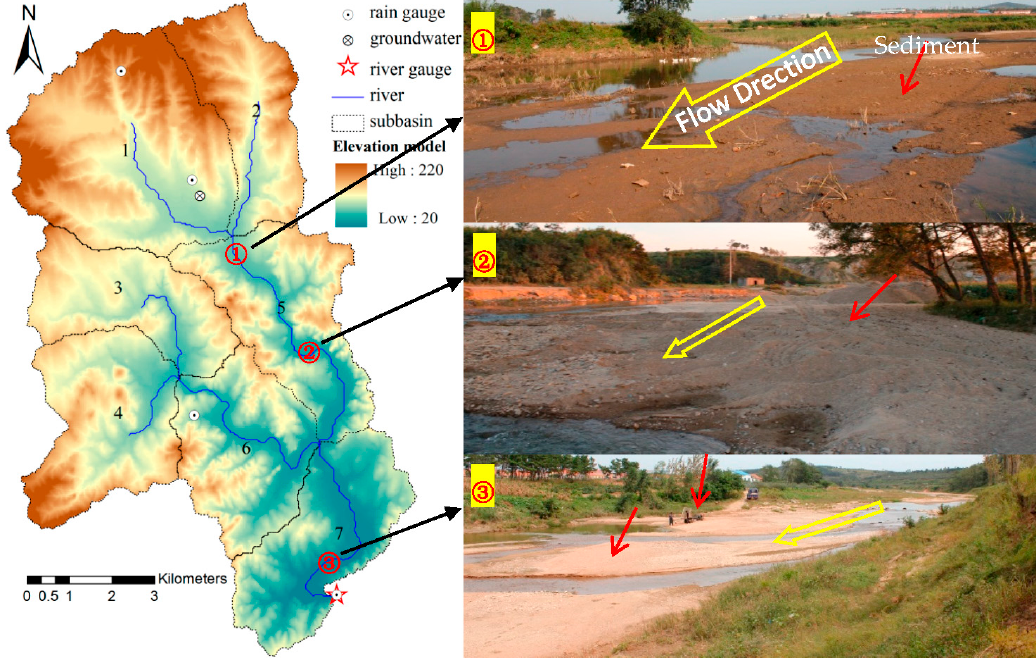
Figure 12. Photographic evidences of deposition sediments in the main channels.